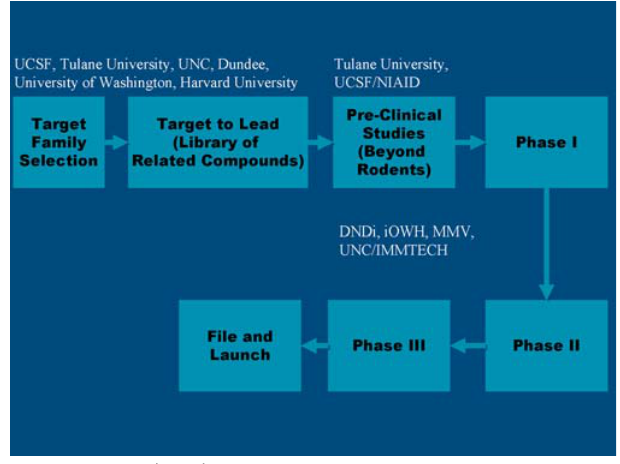
Figure 1. The Pipeline of Drug